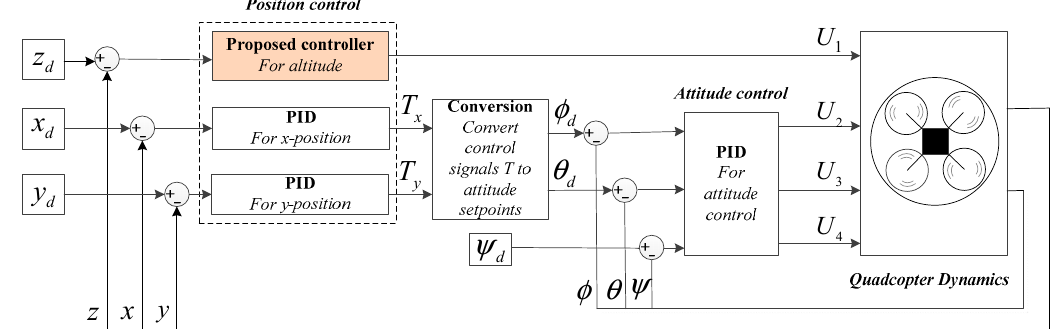
Figure 2. Full quadcopter controller scheme. The proposed algorithm is applied to the altitude control while conventional proportional–integral–derivative (PID) controllers are used for horizontal position and attitude control.